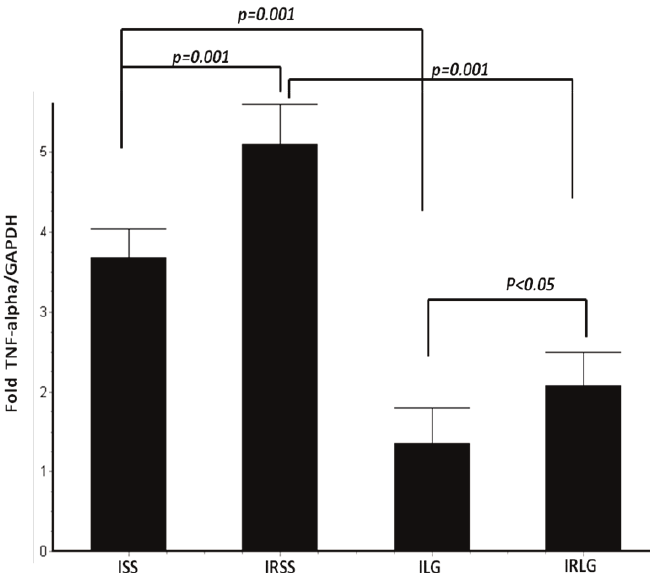
FIGURE 4 - TNF-alpha/GAPDH expression in the I-SS (3.69±0.362), IR-SS (5.10±0.497), I-LG (1.356±0.443) and IR-LG (2.075±0.416); IL6/ GAPDH expression in the I-SS group (2.21±0.14), IR-SS (4.76±0.372), I-LG (1.6±0.052) and IR-LG (2.73±0.121). ANOVA followed by Tukey Test